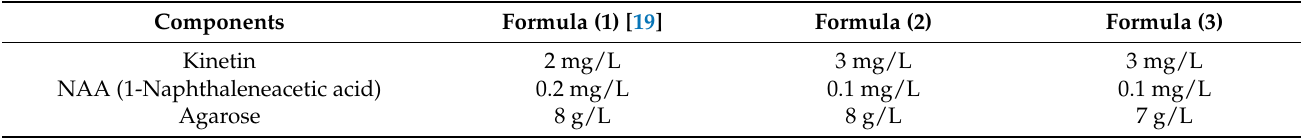
Table A2. Comparison of regeneration media with different cytokinin to auxin